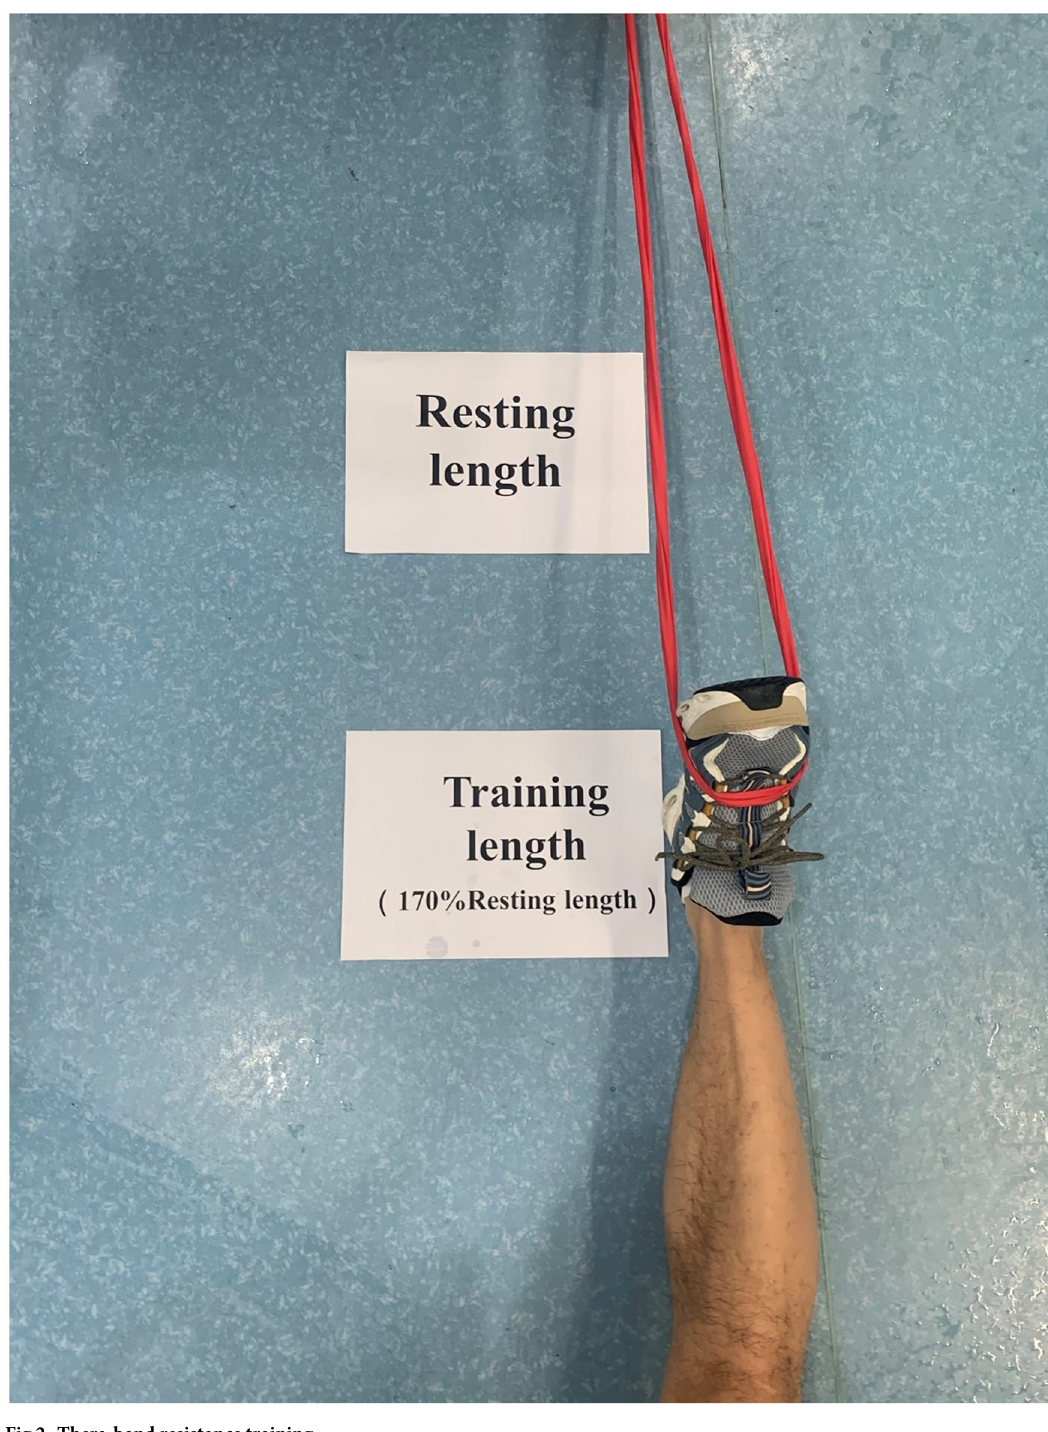
Fig 2. Thera-band resistance training.